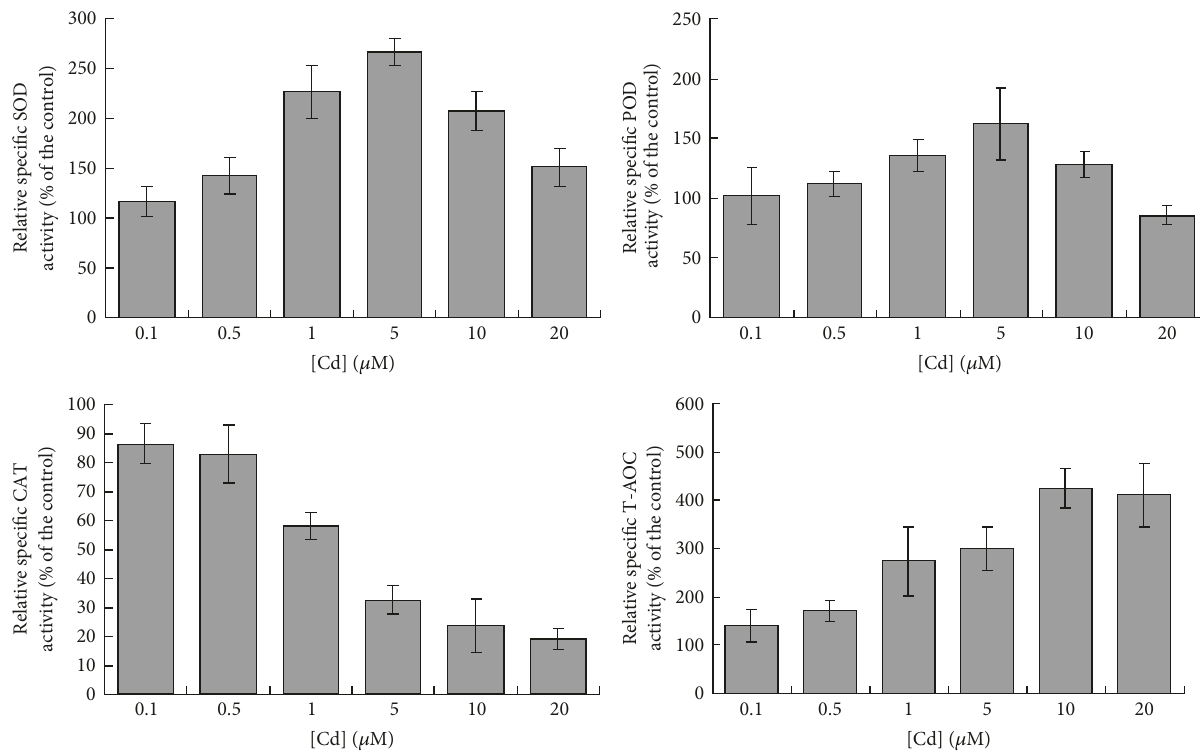
Figure 5: Dependence of relative specific enzyme activities of SOD, POD, CAT, and T-AOC on various Cd concentrations for 4